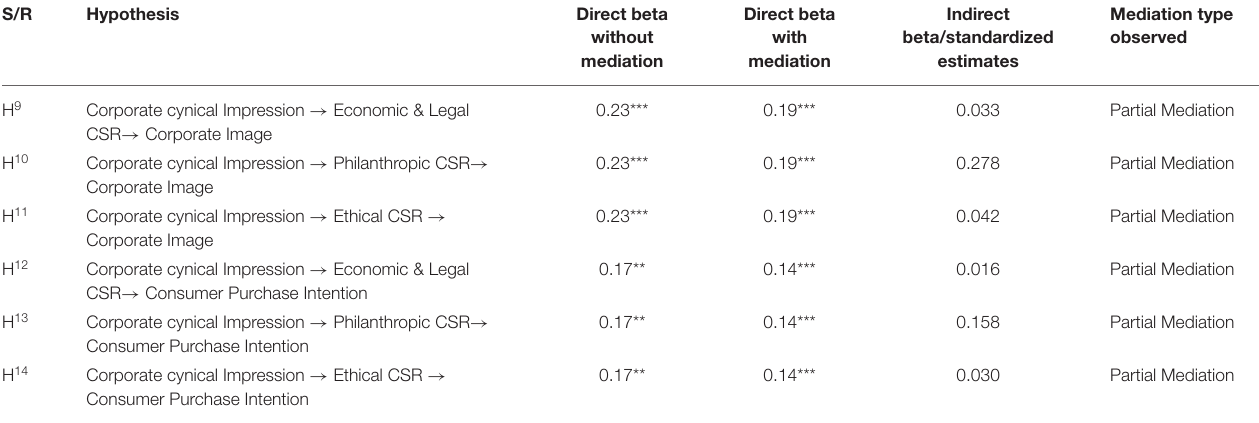
TABLE 8 | Results of indirect